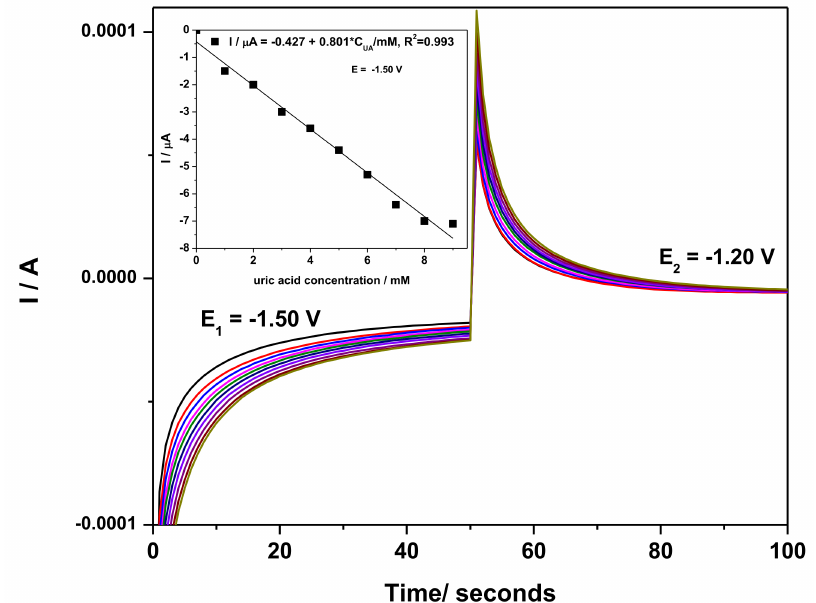
Figure 8. Two detection potential levels-based chronoamperometry recorded at PE_03 paste electrode in 0.1 M NaOH supporting electrolyte (black line) and in the presence of 1–9 mM UA concentrations at the electrodes (colored lines).; Inset: Calibration plots of currents vs. AU concentrations at E = − 1.50 V/SCE; no linear dependence was found at − 1.20